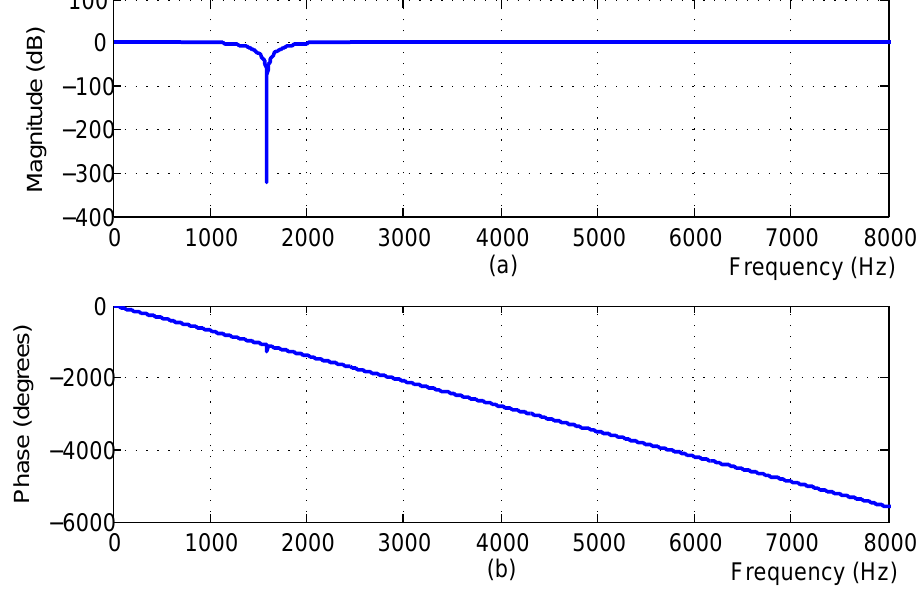
Figure 8. The proposed notch filter frequency response: ( a ) The attenuation curve; ( b ) The